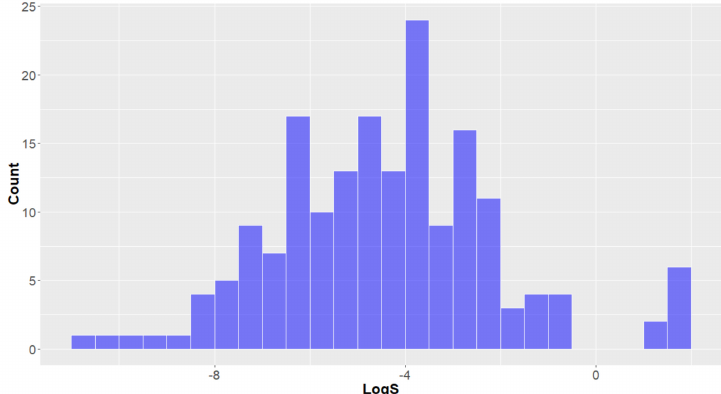
Figure 12. The statistical distribution of the LogS of all analysed compounds. Total number of compounds =